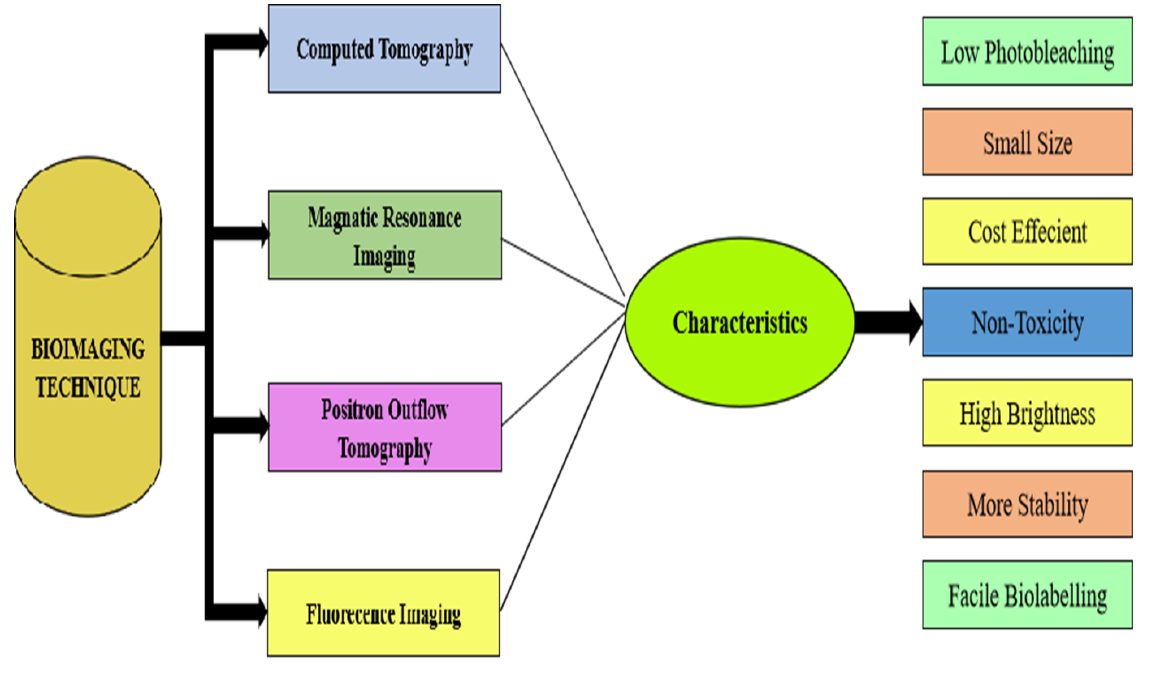
Figure 7. Left side shows different techniques used for bio-imaging. Right side demonstrates various feature associated with bio ‐ imaging.